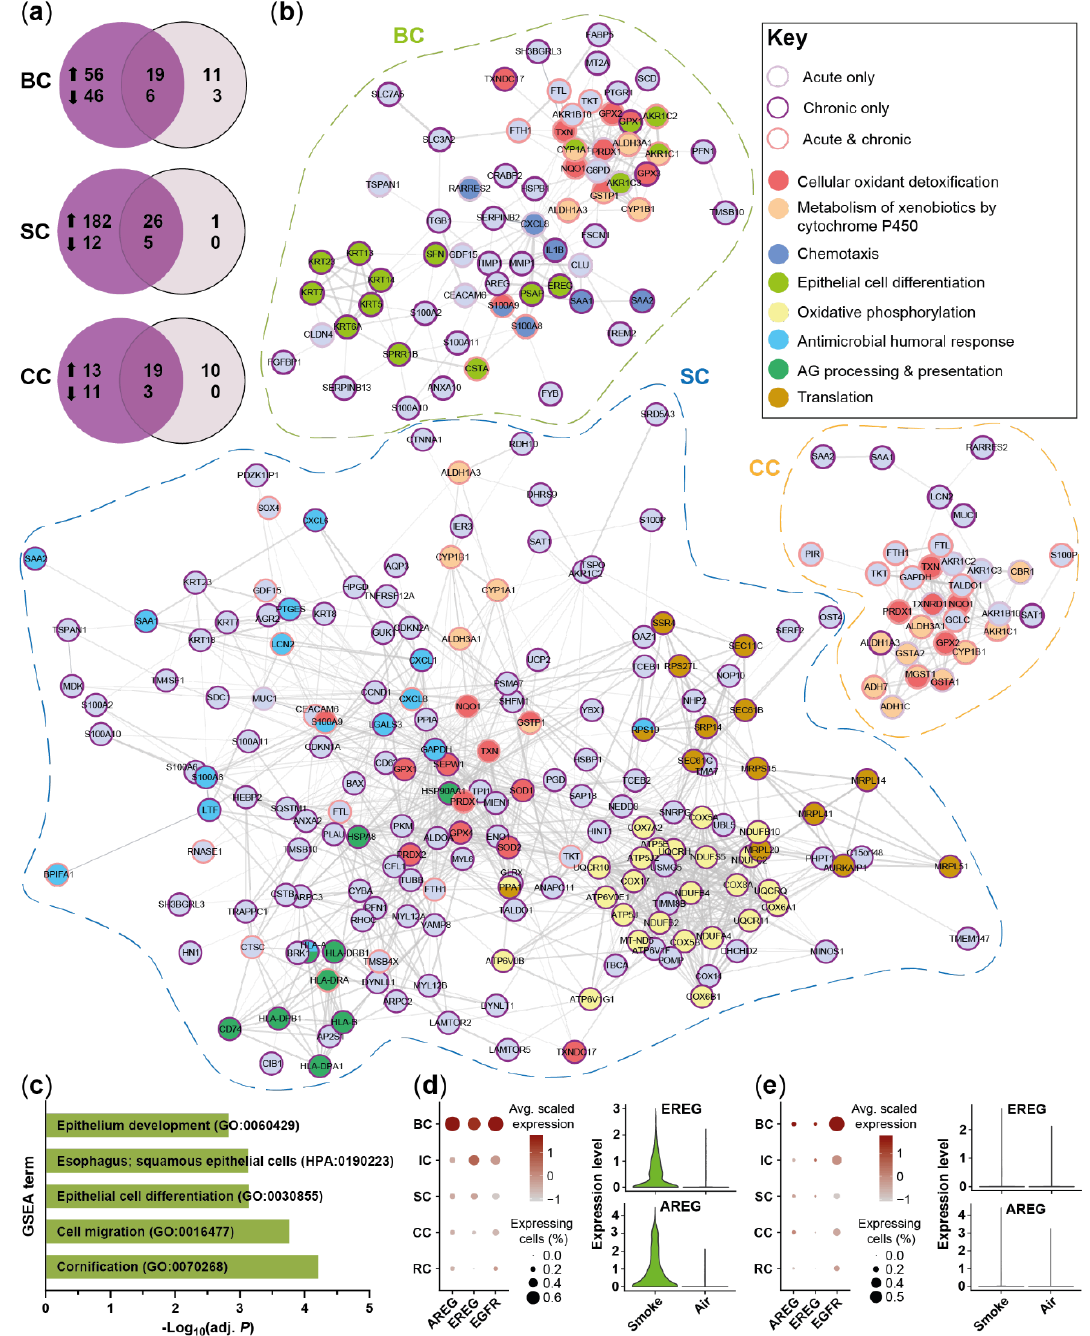
Figure 6. Differentiation of acute and chronic smoke exposure-induced molecular responses. ( a ) Comparison of significantly up- and down-regulated (adj. p < 0.05, abs. fold change ≥ 1.5) genes in BC, SC and CC after acute smoke exposure and smoke exposure throughout differentiation compared to air controls. ( b ) Functional network analysis based on the genes up-regulated by acute smoke exposure and/or smoke exposure throughout differentiation in BC, SC and CC. Node (gene) borders indicate whether the respective gene is up-regulated by acute or chronic smoke exposure or both. Node colors refer to selected molecular mechanisms that are significantly associated (adj. p < 0.05) with the gene set of the respective cell types. ( c ) Selected molecular processes identified by GSEA that are significantly (adj. p < 0.05) associated with the gene set up-regulated in BC only after chronic smoke exposure compared to air controls. ( d , e ) Relative expression of the EGFR-signaling associated genes AREG , EREG and EGFR across SAEC populations after chronic ( d ) and acute ( e ) smoke exposure is illustrated by dot plots. Comparison of normalized EREG and AREG expression in basal cells from smoke-exposed and air control ALI cultures is represented by violin plots.